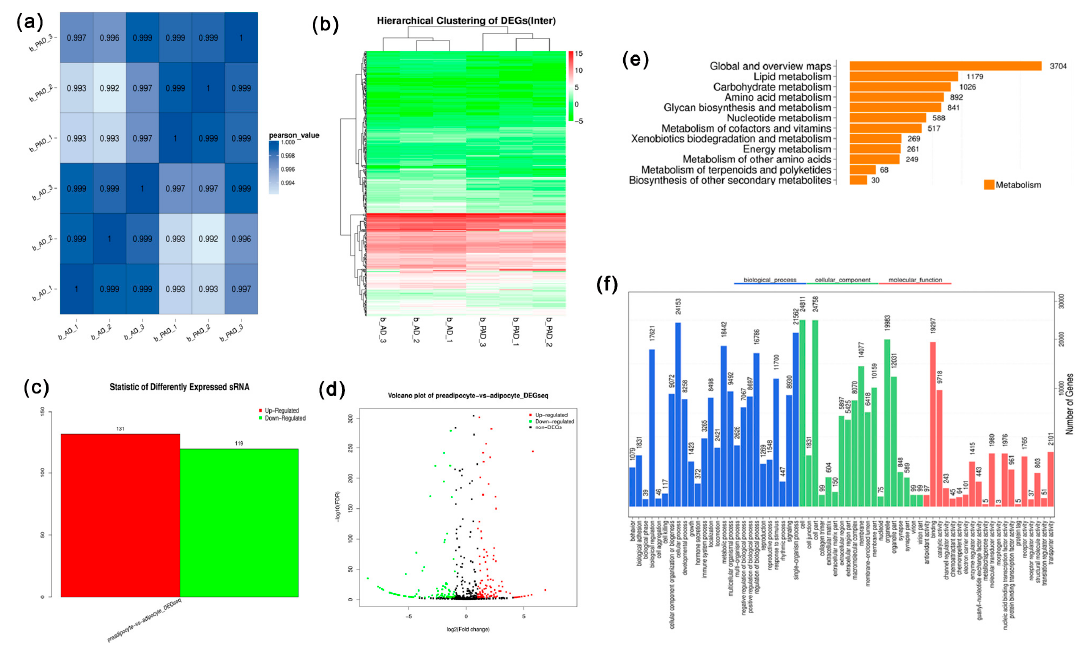
Figure 3. ( a ) Correlation analysis of all samples; ( b ) Hierarchical clustering of all samples; ( c ) Di ff erentially expressed miRNAs between preadipocytes and adipocytes; ( d ) Volcano plot showing di ff erential gene expression profiles of preadipocytes and adipocytes; ( e ) Lipid metabolism of the Kyoto Encyclopedia of Genes and Genomes (KEGG) pathway analysis of target genes; ( f ) Gene Ontology (GO) functional classification of target